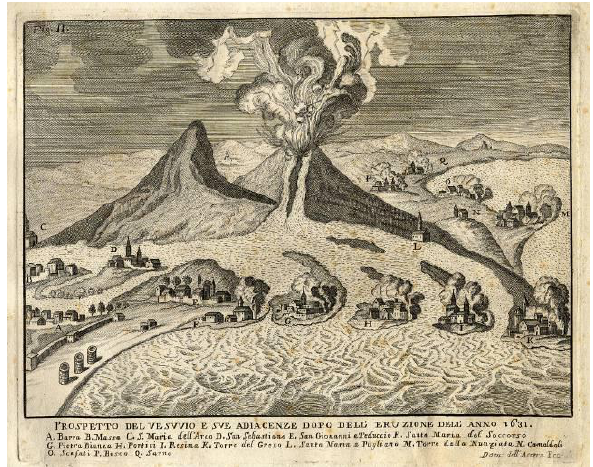
Figure 14. The eruption of Vesuvius in 1631.